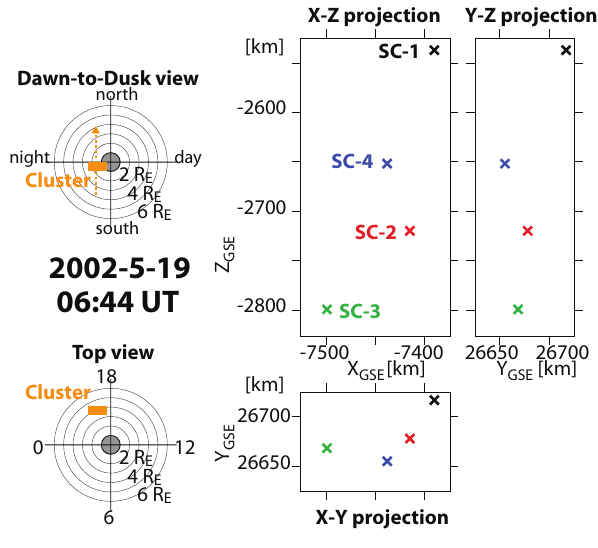
Fig. 2. Location of Cluster at 06:44UT on 19 May 2002 in Geo- centric Solar-Ecliptic (GSE) coordinate. All spacecraft are nearly at X = − 1 . 2 R E , Y = − 4 . 2 R E , Z = − 0 . 4 R E in GSE, or about 19MLT and L = 4 . 4. The right side shows spacecraft (SC) con- stellation (SC-1: black cross, SC-2: red cross, SC-3: green cross, and SC-4: blue cross). The upper panels show the X − Z projection (left) and the Y − Z projection (right), and the lower panel shows the X − Y